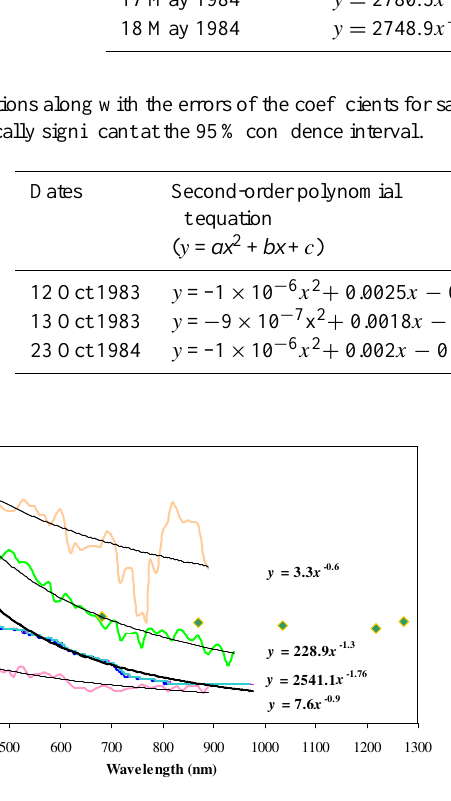
Figure 1. Spectral dependence of the water albedo throughout the spectrum from the UV to the near-infrared. Green line: Black Sea. (Pink, cyan, blue, deep pink) lines: Lake Ladoga. Burlywood line: Atlantic Ocean (12 July 1974). Dark green squares: NASA values (Atlantic Ocean, 13 September 2000). Rose line: Sea of Azov (15 October